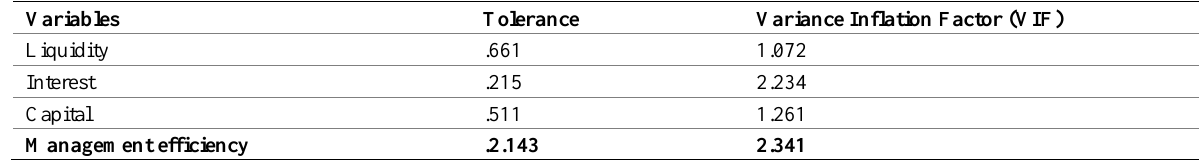
Table 3: Multicollinearity Test